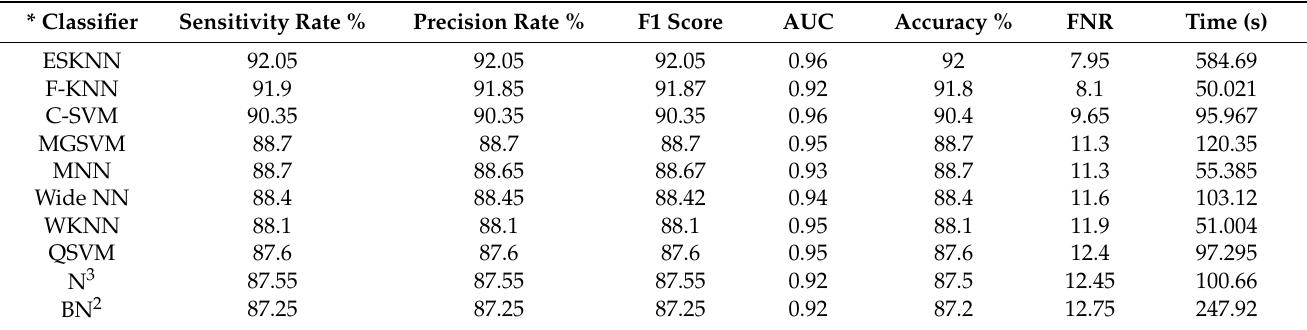
Table 2. Classification results of original dataset after deep feature extraction using